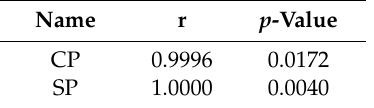
Table 4. Pearson correlation coefficient between preference rating and index (CP, SP).